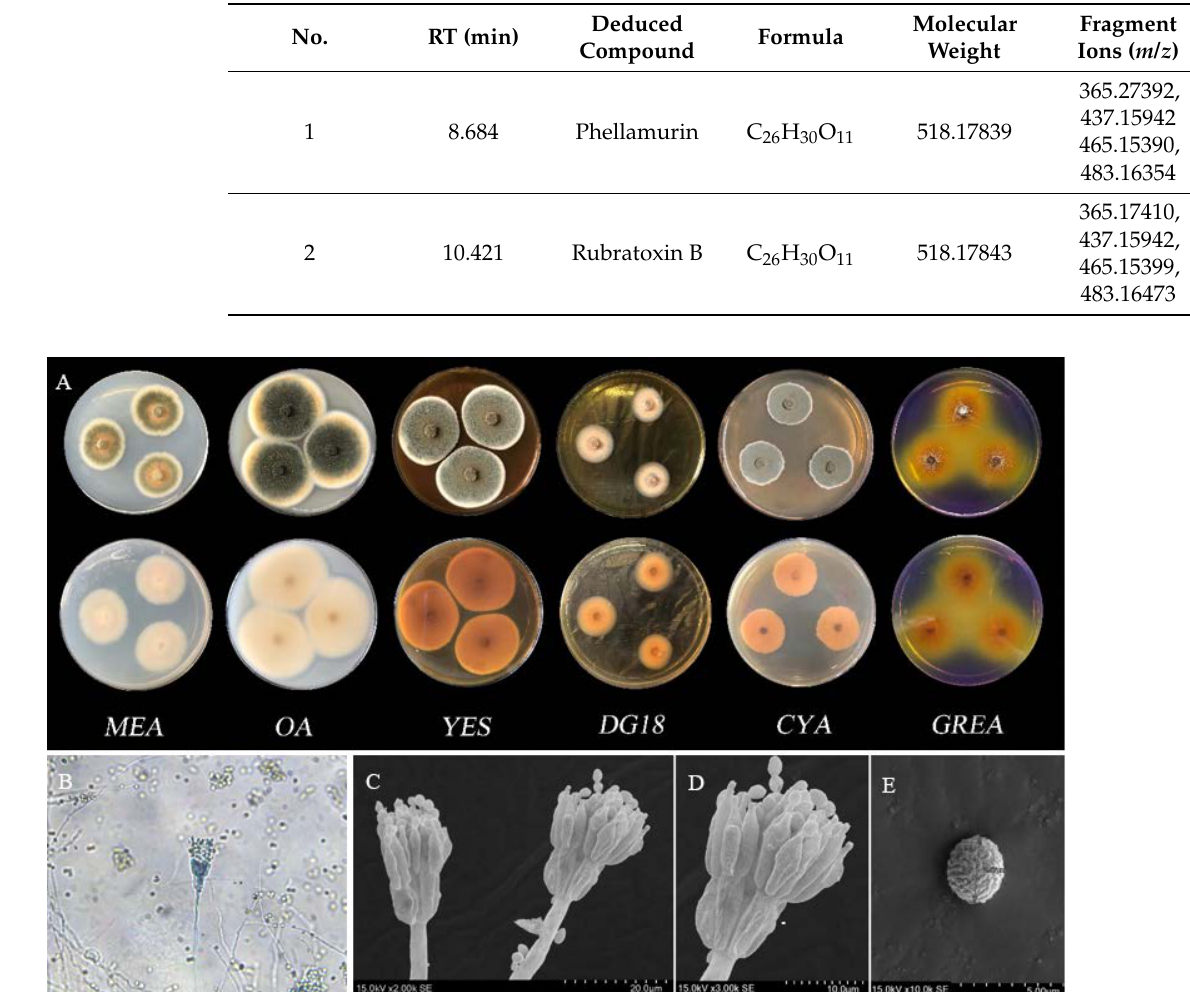
Figure 5. Morphological characters of Talaromyces purpureogenus BS5. ( A ) Colonies from left to right as follows: (top row) MEA, OA, YES, DG18, CYA and CREA obverse view; (bottom row) MEA, OA, YES, DG18, CYA and CREA reverse view. ( B ) Diagram of OM (Optical Microscope). ( C – E ) Diagram of SEM (Scanning Electron